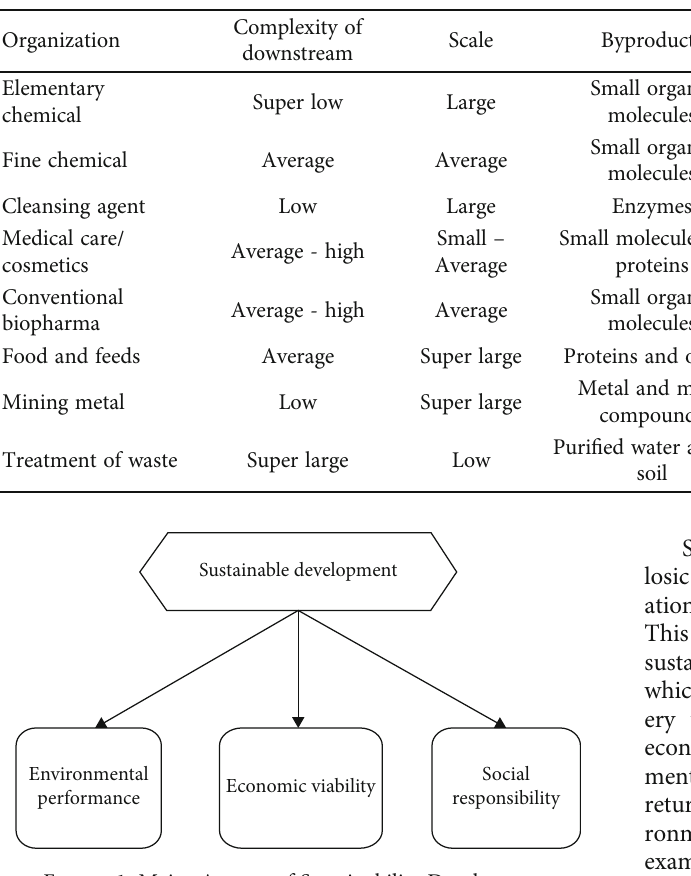
Figure 1: Major Aspects of Sustainability